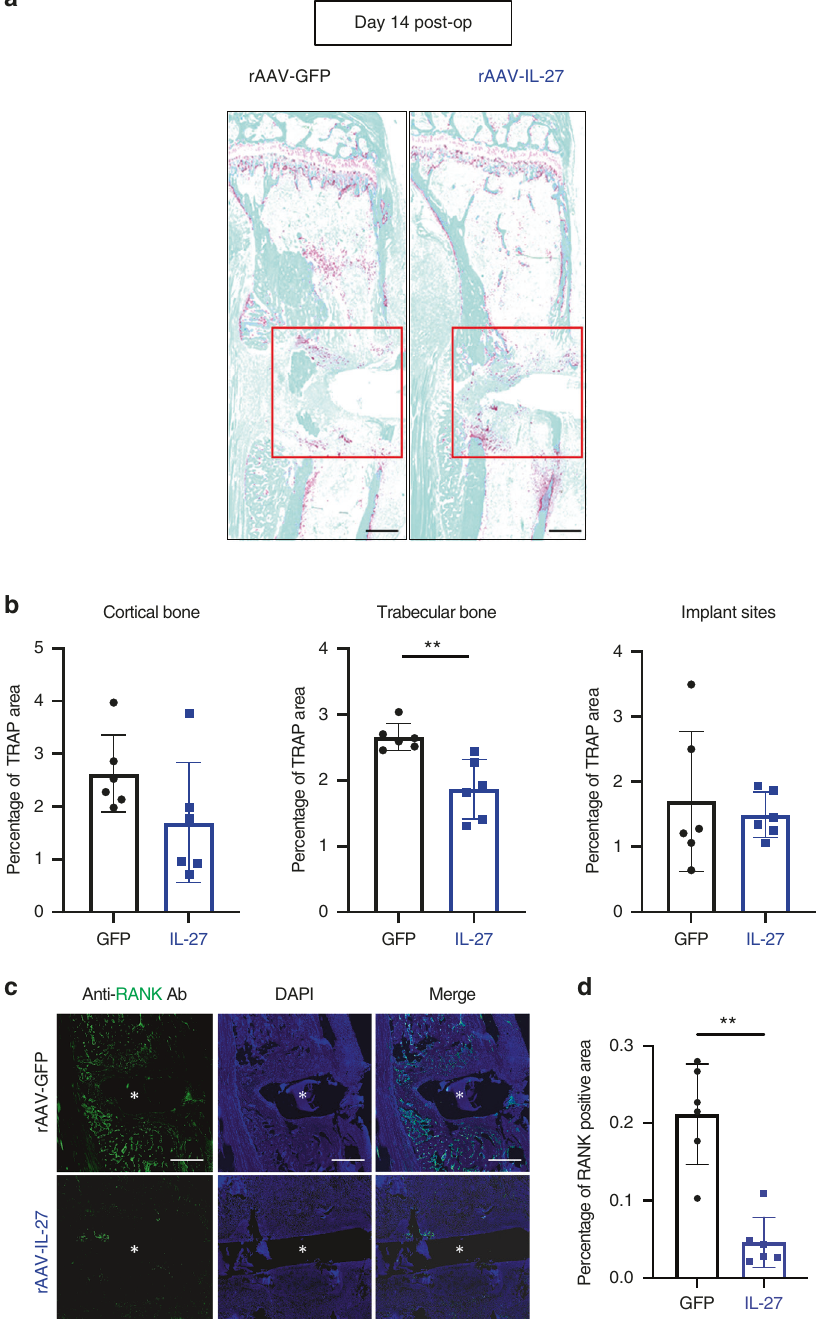
Fig. 5 Systemic IL-27p28 impairs osteoclast formation during implant-associated osteomyelitis. a Tibiae from the mice described in Fig. 3 were processed for histological staining for tartrate-resistance acid phosphatase (TRAP). Representative images at 2× magni fi cation are shown (scale bars = 500 µm). b The TRAP-stained areas within the cortical bone regions, trabecular bone regions, and implant sites (red box) were quanti fi ed as percentages, and the data are presented for each tibia with the mean ± SD for the group ( n = 6, ** P < 0.01, t -test). c Tibia sections were also processed for immuno fl uorescence histochemistry for RANK, and representative images at 200× magni fi cation are shown (scale bar = 500 µm). The white asterisk indicates the hole where the L-shaped pin was inserted. d The RANK-stained area in the bone marrow surrounding the infection site was quanti fi ed as a percentage, and the data are presented for each tibia with the mean ± SD for the group ( n = 6, ** P < 0.01, t host susceptibility to osteomyelitis. In sharp contrast, exogenous (Fig. 7). At the onset of S. aureus osteomyelitis, osteoblasts and expression of IL-27 induces the accumulation of proin fl ammatory macrophages induce IL-27 secretion via TLR activation, and this IL-17-producing ROR γ t + neutrophils, which leads to decreased process is dependent on the autoregulatory IL-27/IL-27R α signaling pathway. However, endogenous IL-27 is not suf fi cient to in fl uence abscess formation and increased bacterial clearance at the infection